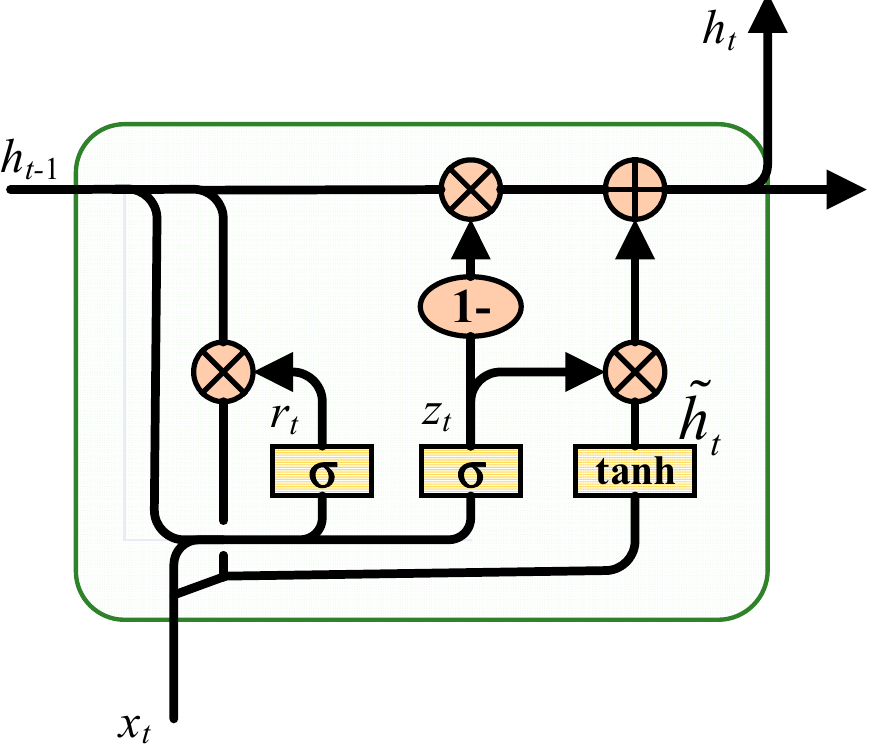
Figure 2. Inner structure of the gated recurrent unit network (GRU) .